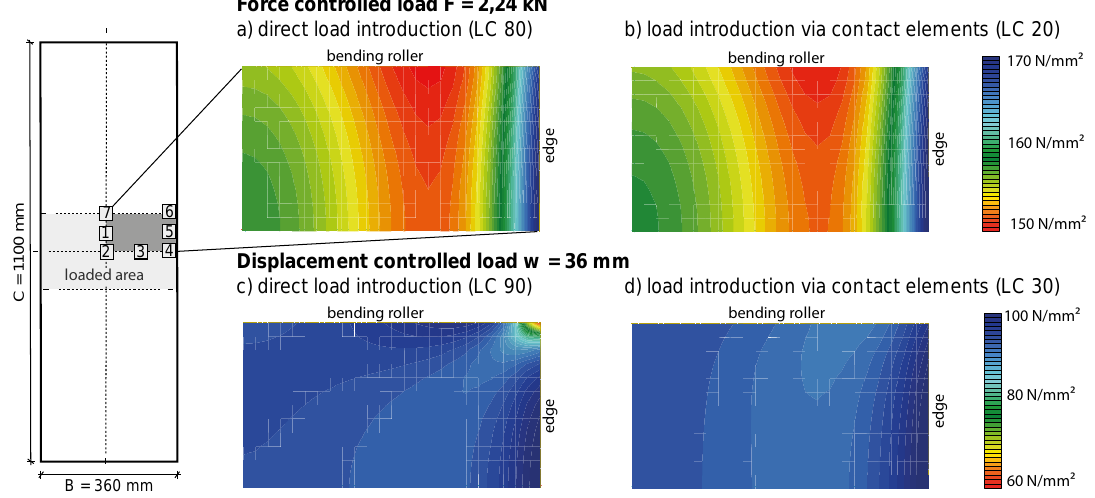
Fig. 10 Principle tensile stress distribution at R = 1083 mm h = 8 mm, C = 1100 mm and B = 360 mm To rate the model, the numerical load values at each strength level (FT, HS, AN) are compared to the measured load. An accordance of minimum 80 % is assumed as valid. To get an overview of the validation, Fig. 11 shows all validated strength levels in dependence of the parameter combination. The radius is shown along the y-axis, the thickness along the x-axis. The altered green colour of the marks describes the chord length and in accordance the span of the test rig (dark green represents the chord length 1100 mm, green the chord length 900 mm and light green the chord length 700 mm). The strength level reached is presented by different marks. A square indicates a minimum stress level of 200 N/mm², the triangle represents a minimum stress level of 120/mm² and the dot a minimum stress level of 70 N/mm². Everything below 70 N/mm² is marked with a red cross; empty boxes represent parameter combinations, which were not tested experimentally and therefore are not